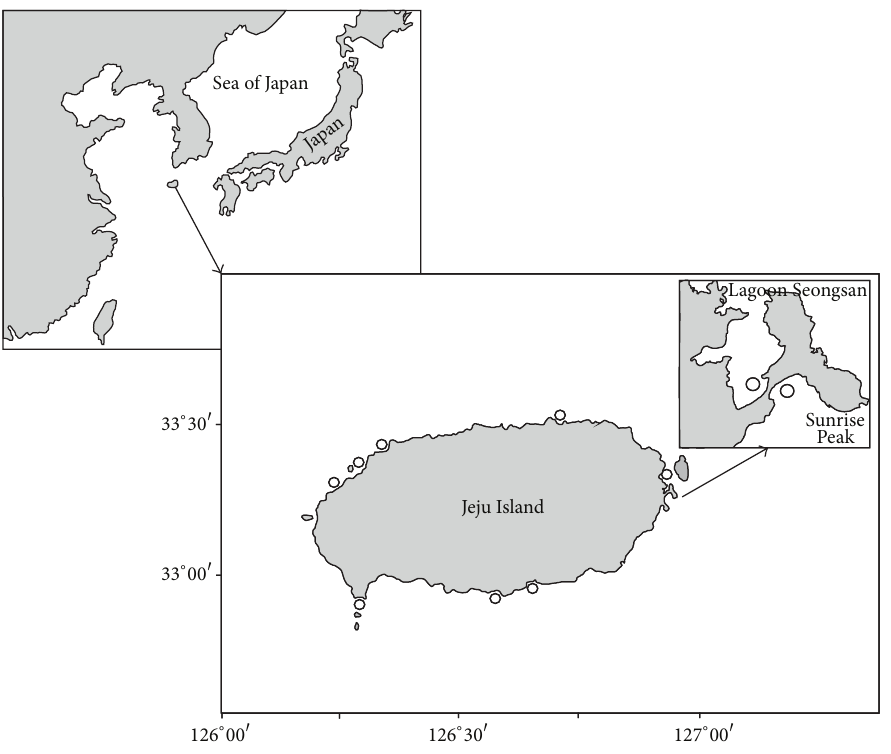
Figure 1: Sites of searches for Ruditapes bruguieri shells along the coasts of Jeju Island, South